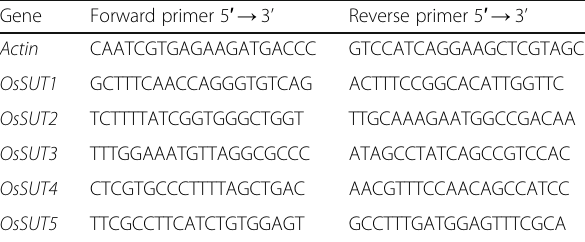
Table 6 Sequences of primers for Actin and sucrose